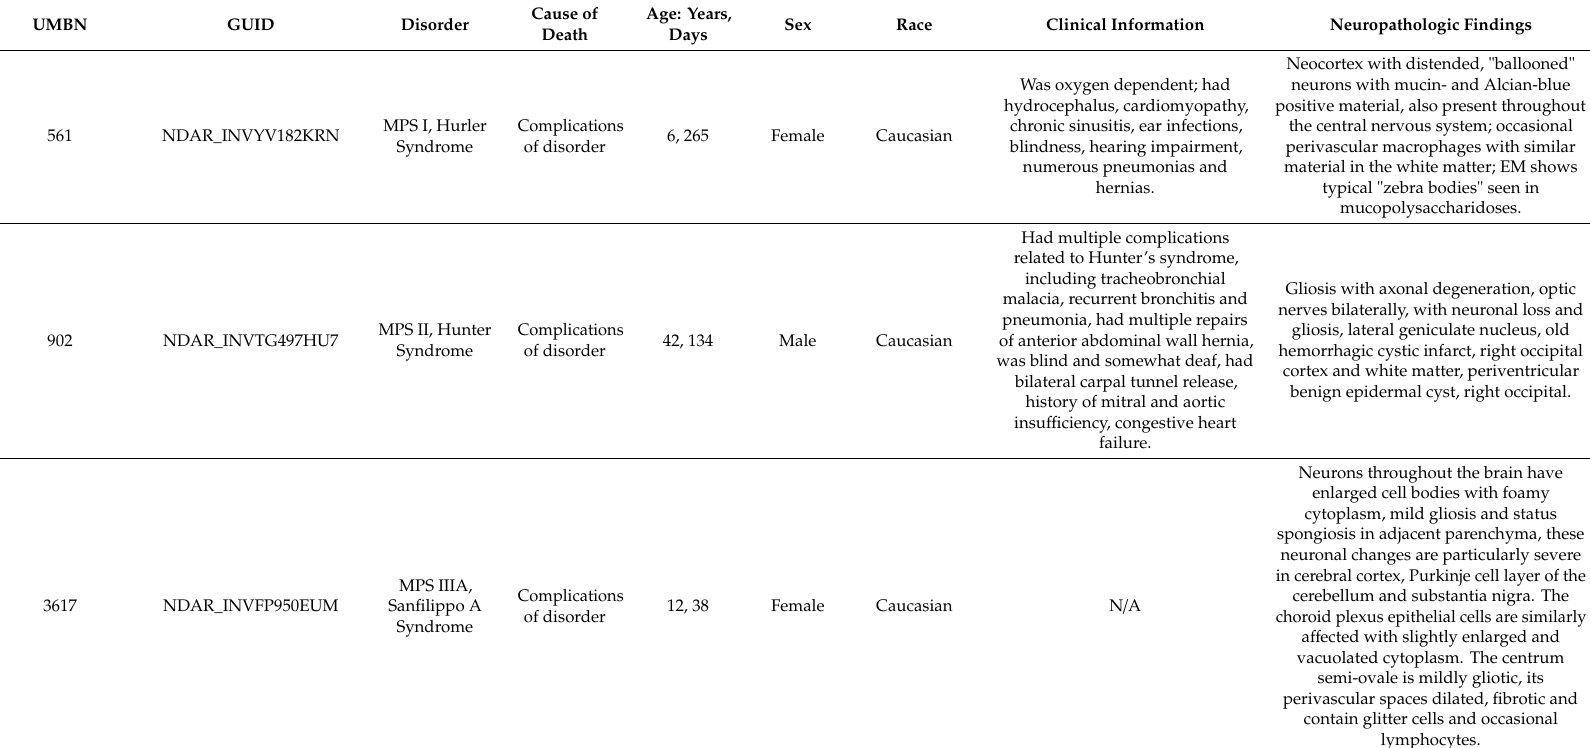
Table 1. Mucopolysaccharidoses (MPS) patients and control subjects used in the